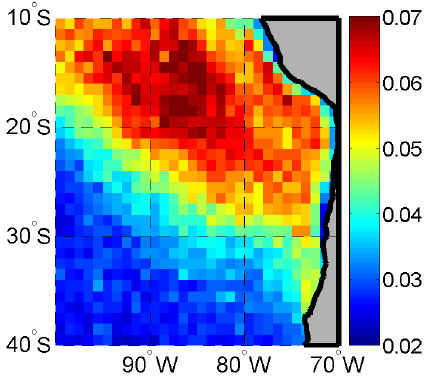
Fig. 5. Fractional contribution of N , or essentially N d , to albedo variance approximated by multiplying the contribution of N to τ variance (Fig. 4b) by the contribution of α cld to albedo variance (Fig. 3b).